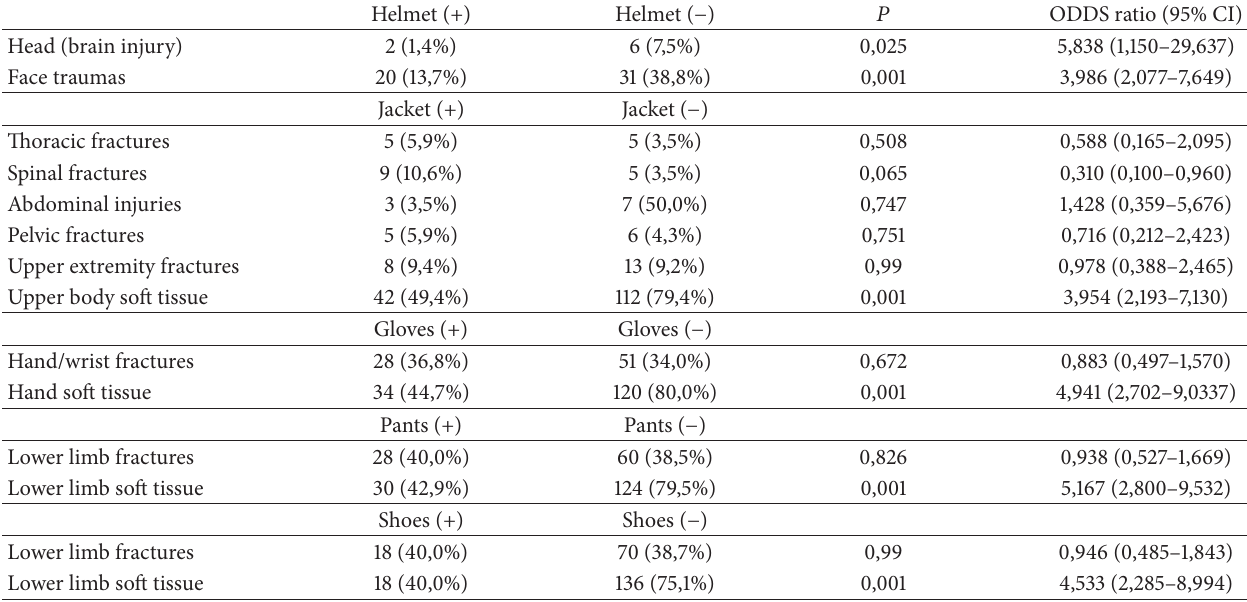
Table 2: Effects of protective wearing on injury.